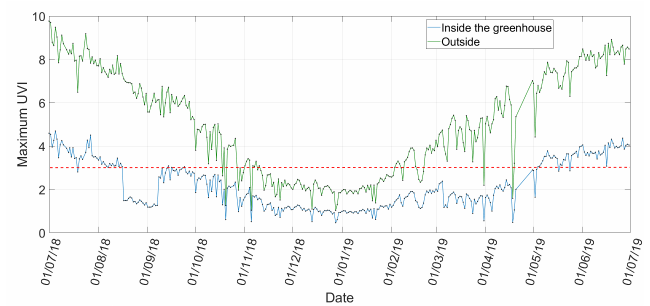
Figure 7. Maximum daily UVI outside and inside the greenhouse.